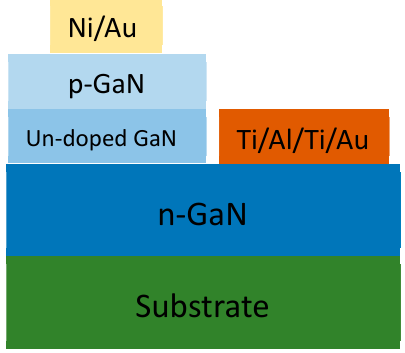
Figure 5. Cross-sectional schematic of GaN PIN diode structure for α -particle detector.